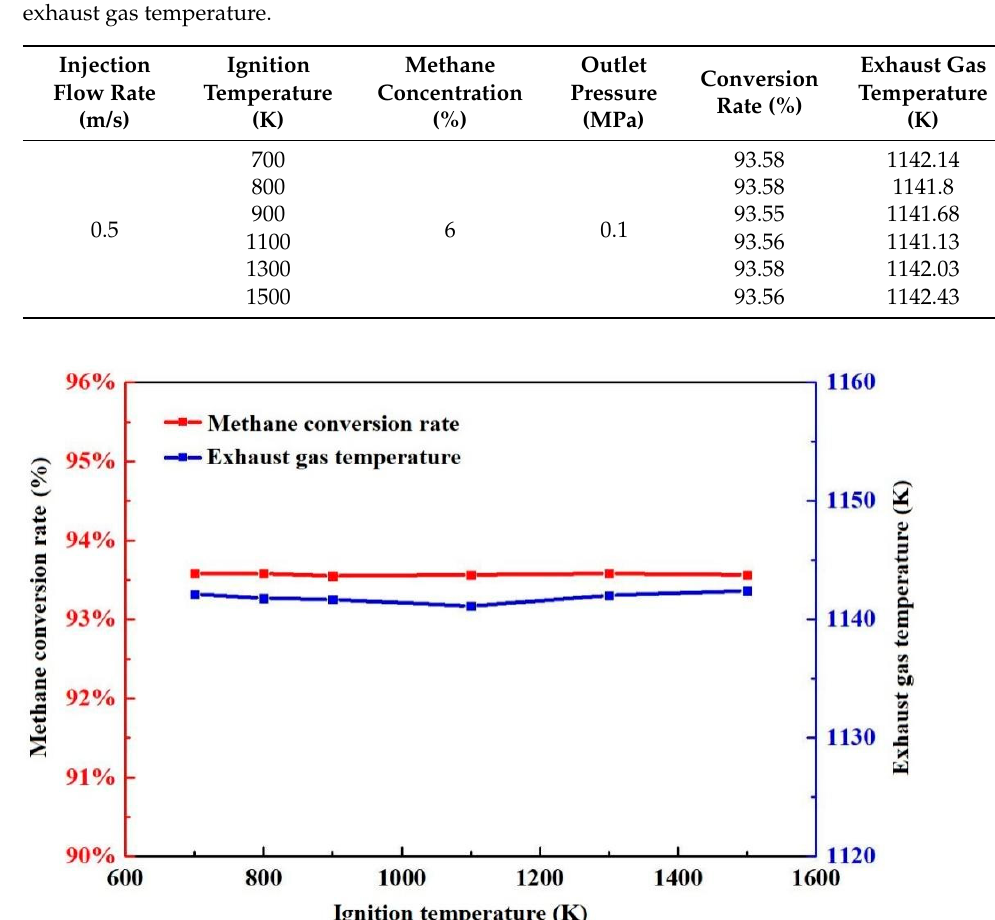
Figure 9. Methane conversion rate and exhaust gas temperature at different ignition temperatures.